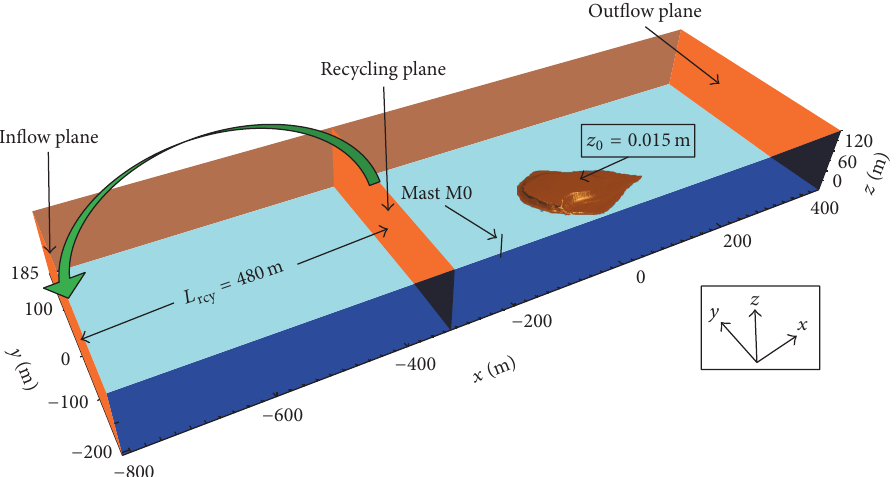
Figure 2: Picture of the computational domain with an explanation of the recycling technique used in the simulation of the 270 ∘ wind direction. A similar setting is used for the 239 ∘ wind direction, but with the 𝑥 -axis aligned with that direction.